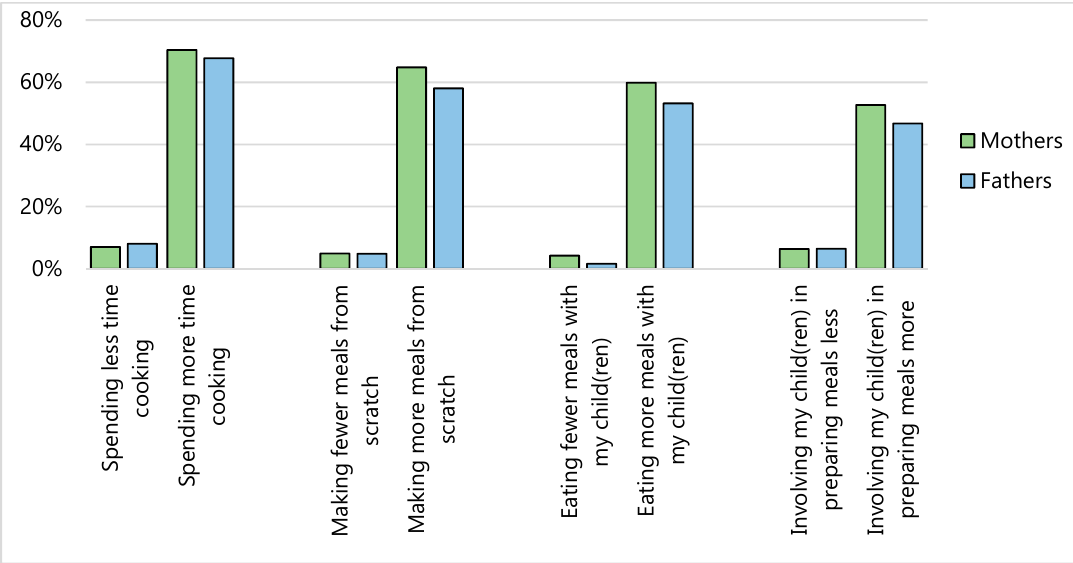
Figure 2. Reported changes in meal routines among mothers ( n = 142) and fathers ( n = 62) since COVID-19.